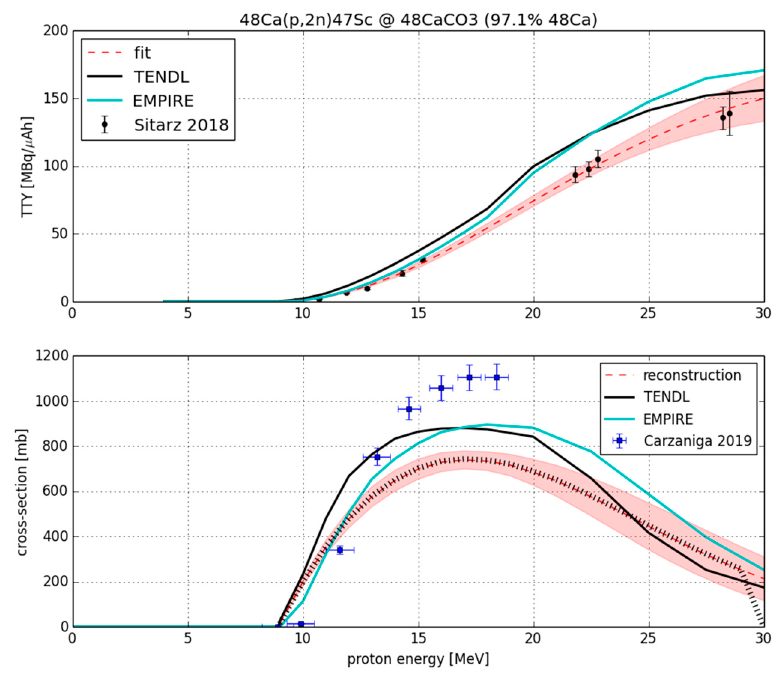
Figure 4. Reconstruction of 48 Ca(p,2n) 47 Sc cross-section (bottom) based on the fit to TTY data on 48 CaCO 48 Ca (top). The cross-section data points are taken from [35]. 3 enriched in 97.1%